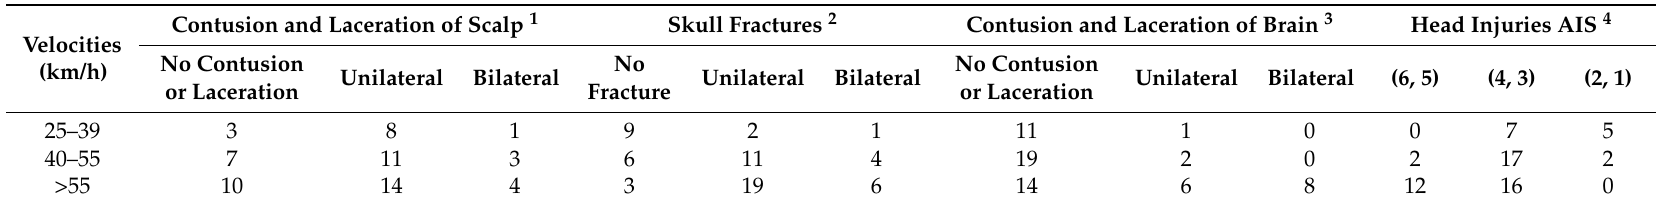
Table 2. Comparison of head injuries at different collision velocities.